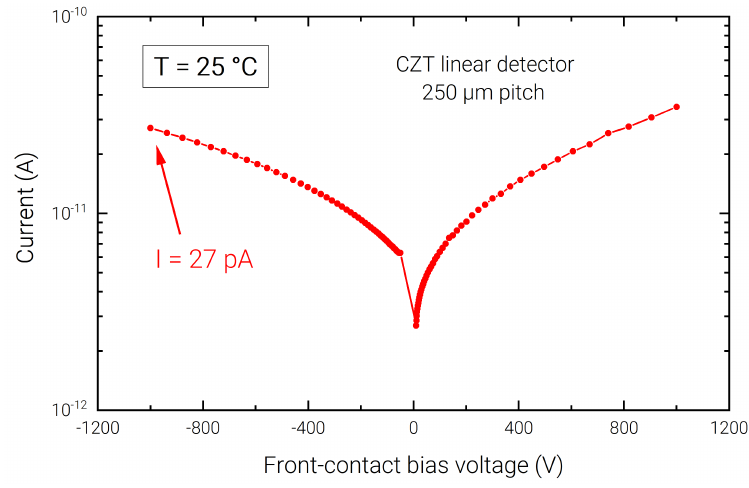
Figure 2. I–V characteristic of a pixel of the CZT linear array at +25